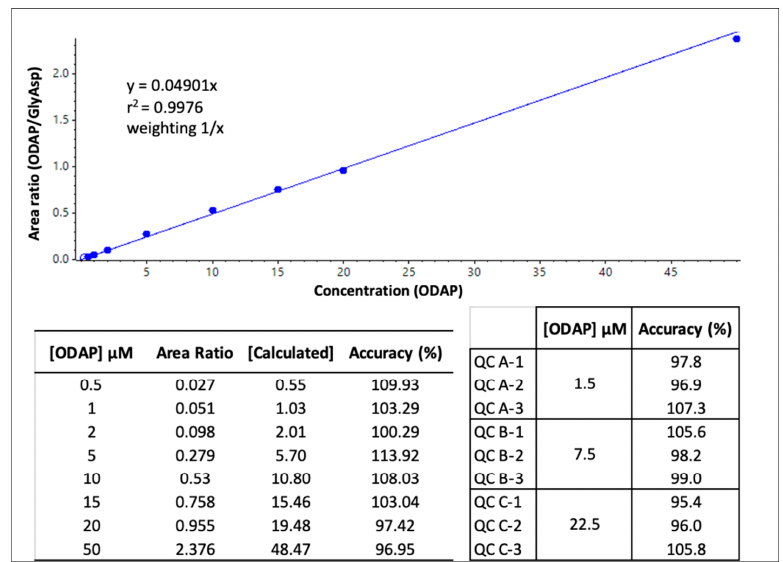
Figure 2. β -ODAP calibration curve, using the area ratio of ODAP/Gly-Asp LC-MRM peaks, as well as accuracy data for each calibration standard and triplicate QC samples at three concentration levels.